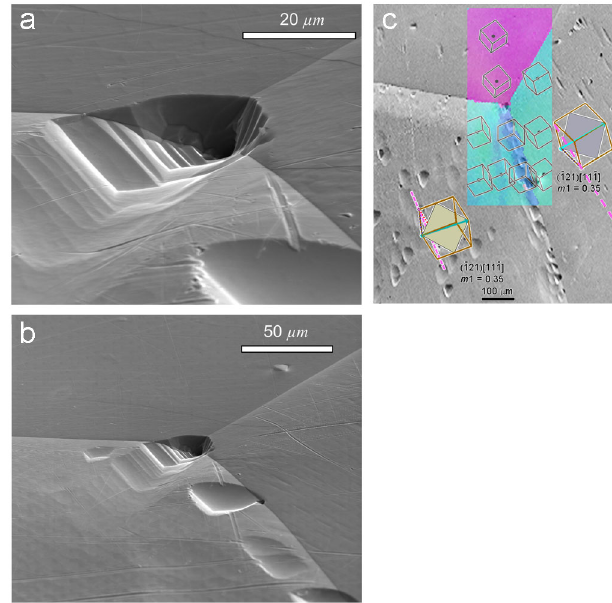
FIG. 7. Tilted SEM images showing an etch pit at a tricrystal junction of sample No. 9 (a), (b). The neighborhood of the magnified image in (a) is shown in (b). A normal direction crystal orientation map (untilted view) of the tricrystal junction (c) shows that etch pits in the lower two grains are consistent with screw dislocations where the line direction is parallel to Burgers vectors indicated with blue arrows on slip planes. The lighter plane has a normal direction that comes out of the surface and darker plane into the surface. The Schmid factor m is indicated, e.g. m 1 ¼ 0 : 35 is the highest resolved shear stress operating on a slip system in the grain, with a biaxial tension stress